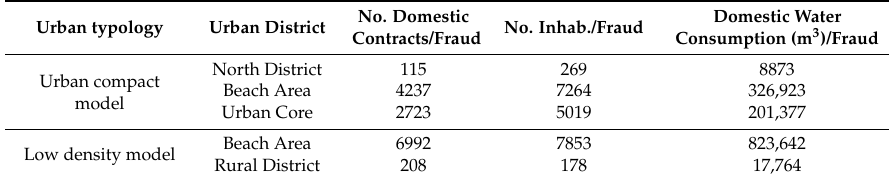
Table 3. Unauthorised domestic water consumption according to the different socio-demographic and economic characteristics of the city of Alicante